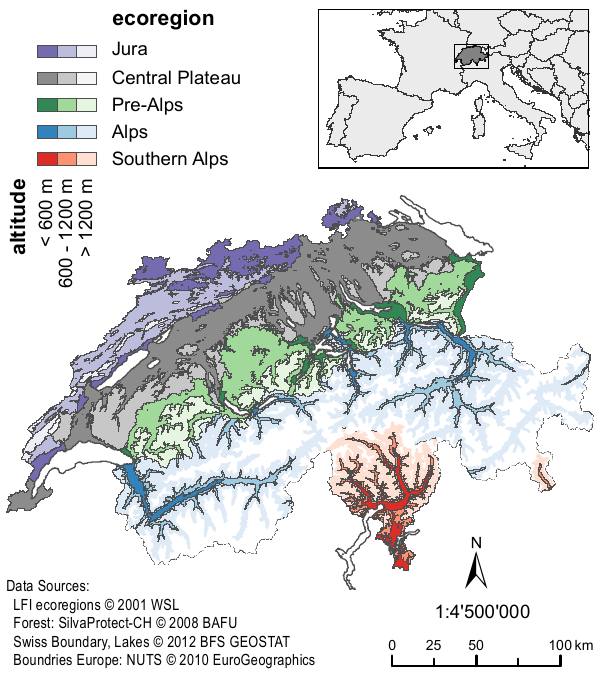
Figure 1. Ecoregions of Switzerland, stratified by altitudinal class.